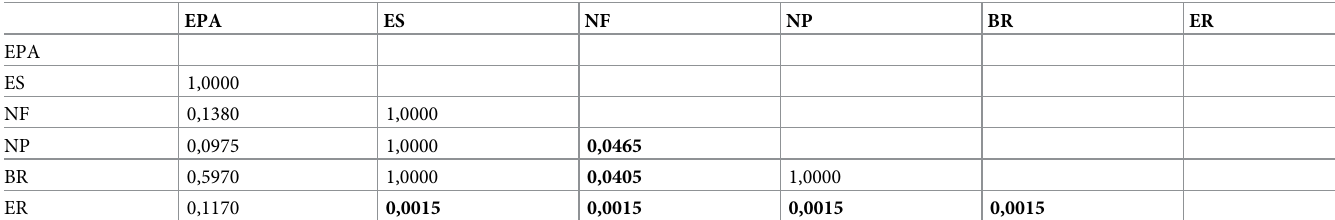
Table 3. P-values of ANOSIM-pairwise comparisons with Bonferroni correction between Protected Areas categories, according to analysis and methods of diagnoses. EPA ES NF NP BR ER EPA NF 0,1380 1,0000 NP 1,0000 0,0465